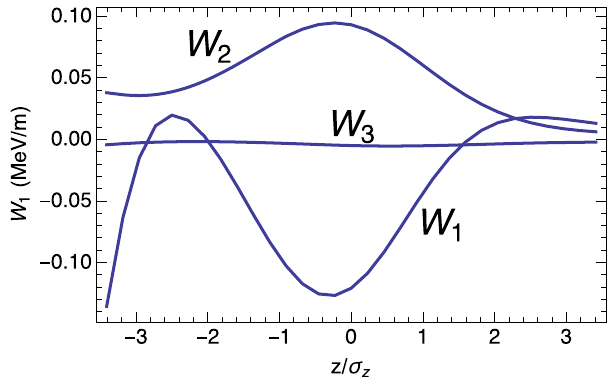
FIG. 4. Plot the functions W 1 ð z Þ , W 2 ð z Þ , and W 3 ð z Þ for s ¼ 0 . 99 m. The sum of these functions gives the solid line in Fig. 3(c).